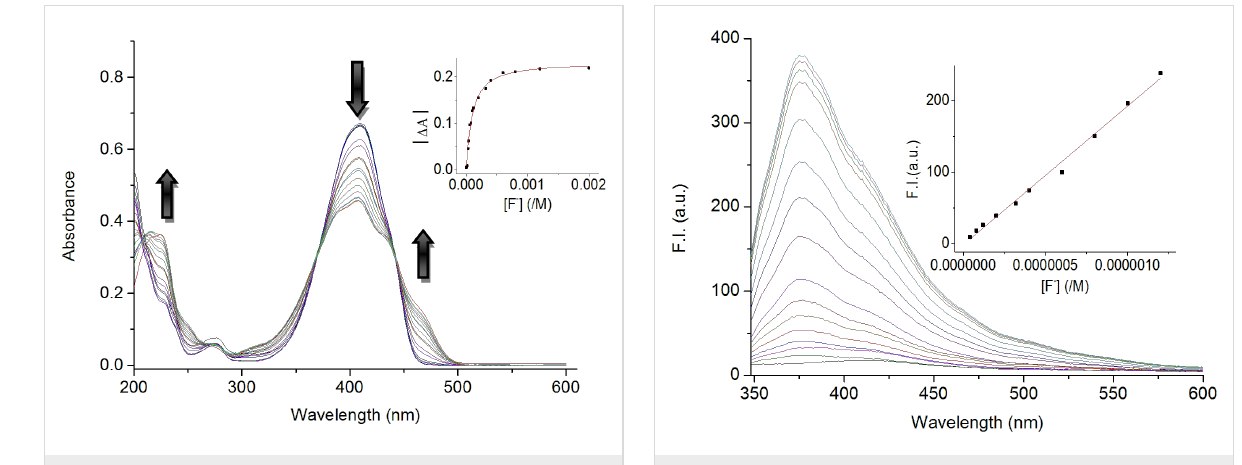
Figure 2: UV − vis absorption spectra of BIP (4 × 10 − 5 M) in CH 3 CN after the addition of 0–50 equiv of TBAF. Insert: Non-linear curve fit of absorbance changes at 410 nm as a function of fluoride concentration.